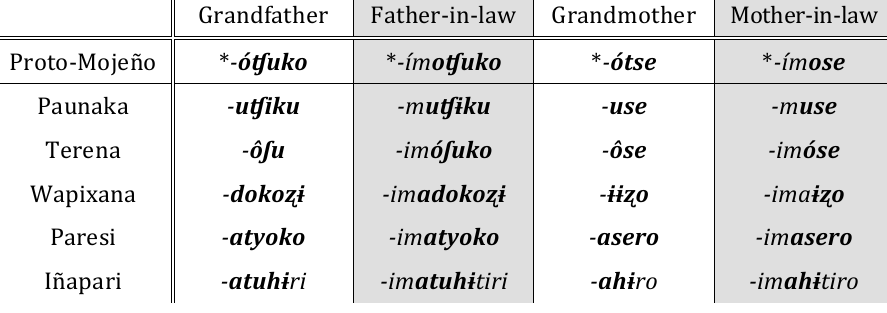
Table 3. Terms for blood and affine relatives in diverse Arawakan